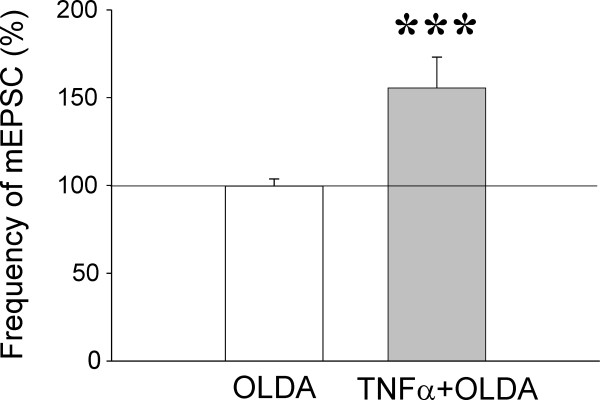
Application of a low concentration of OLDA solution (0.2 μM) did not change mEPSC frequency in neurons, as recorded under control conditions (n = 25). The same OLDA application significantly increased mEPSC frequency in neurons recorded in spinal cord slices incubated with TNFα (60 nM; n = 10; ***P < 0.001). Values are given in percent of the corresponding mEPSC frequency before the OLDA application (100%).